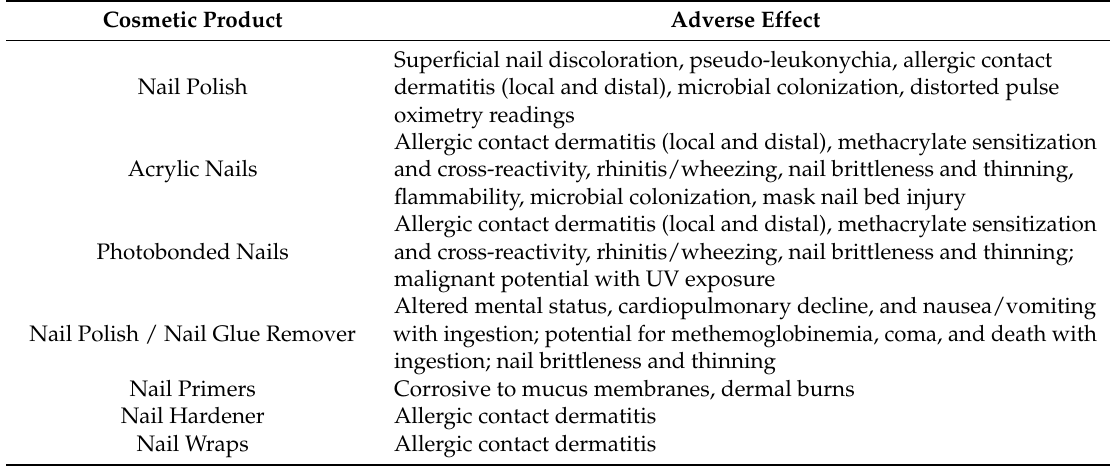
Table 1. Adverse Effects Associated with Nail Cosmetic